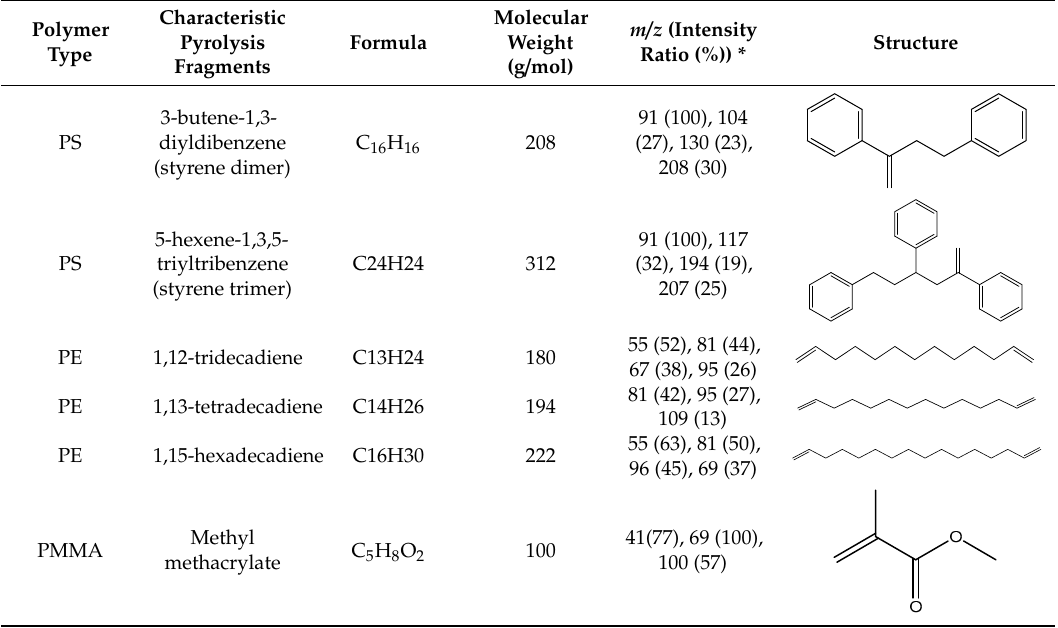
Table 2. Characteristic signals, properties and structure of chosen substances.